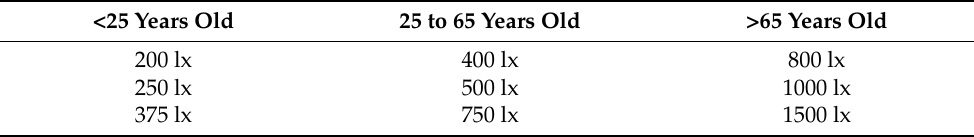
Table 1. Indoor lighting at workplaces. Lx per group of ages